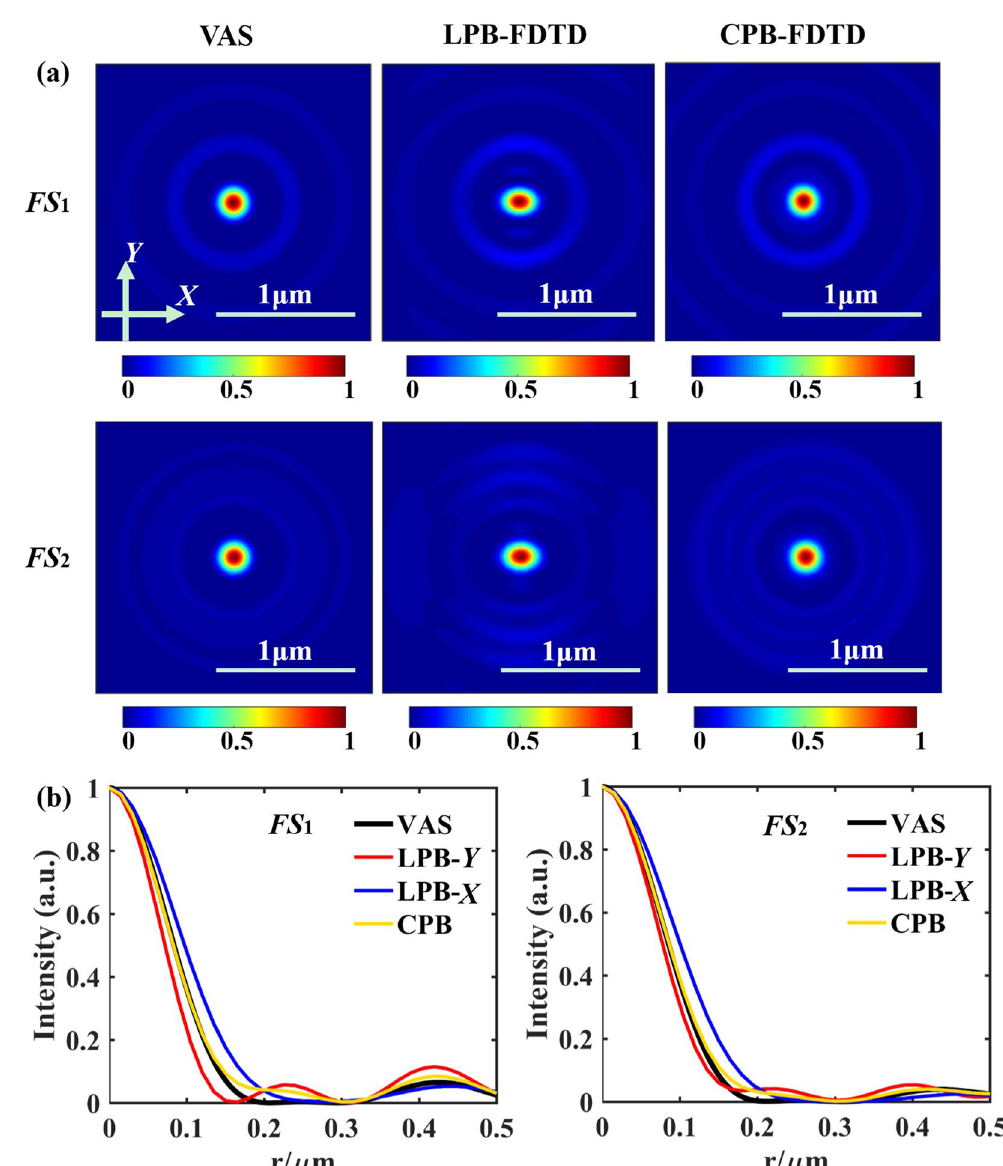
Figure 5. ( a ) Comparison of the electric-field components ( E r ) in the transverse focal planes behind the SOL #1. ( b ) The derived intensity profiles across the focal spots, for focal spot 1( FS 1 ) and focal spot 2 ( FS 2 ),